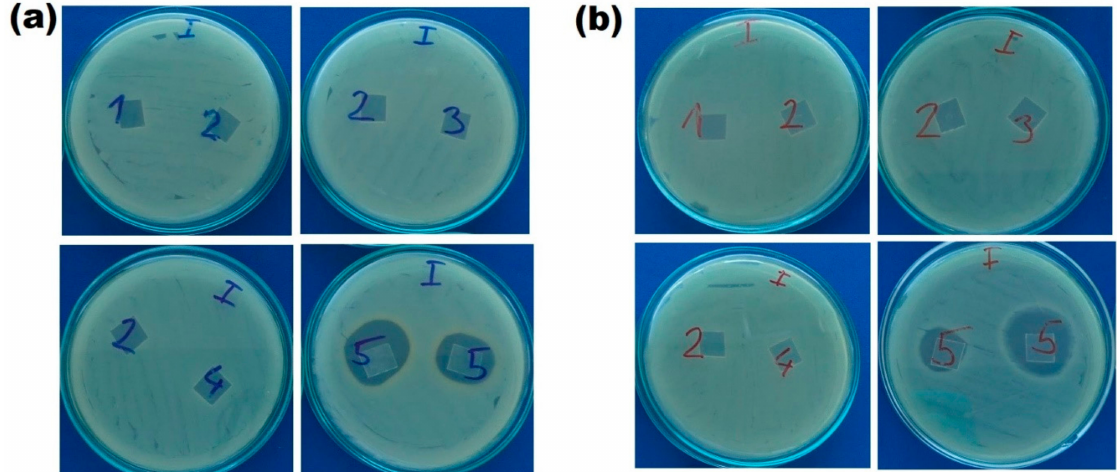
Figure 8. Zone of inhibitions around (1) untreated PLA (2) CS (3) g -CS (4) g -CS-ChS (5) lomefloxacin drug loaded g -CS-ChS coated PLA films against ( a ) S. aureus and ( b ) E. coli .